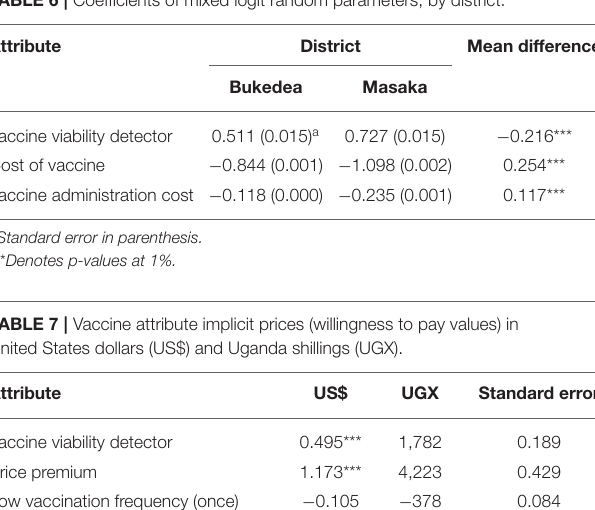
TABLE 6 | Coefficients of mixed logit random parameters, by